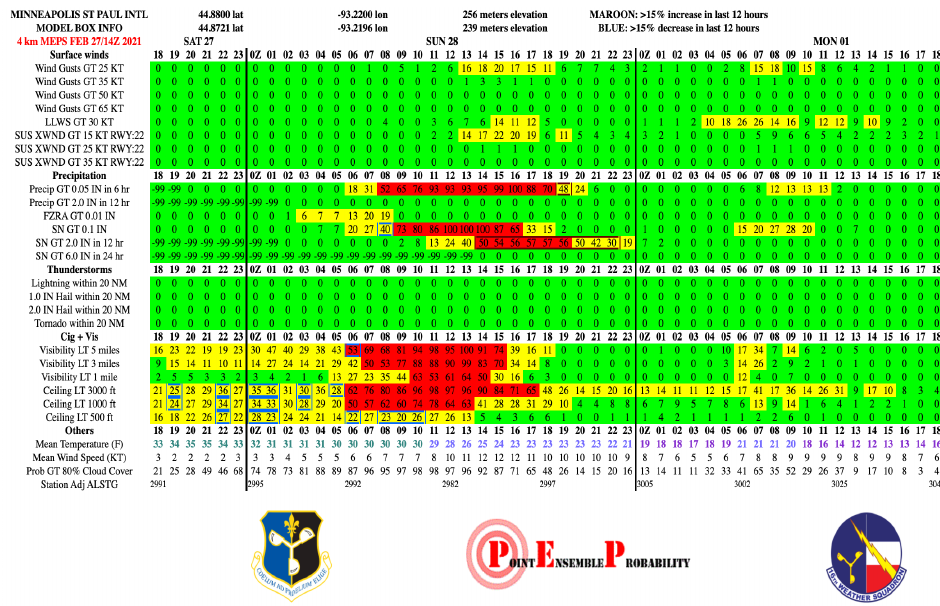
Figure 18. PEP bulletin from the 14 February 2021 1400 UTC run of the “Rolling” MEPS valid for Minneapolis, MN. Variables listed on the left hand side, with probabilities of exceedance for each valid time in rows to the right of the label. Yellow and red coloring designed to draw user attention to higher probabilities. Maroon (blue) box outlines indicate the rolling ensemble has increased (decreased) in probability by at least 15% in the last 12 hours of model runs. Note the elevated risk of snow, somewhat strong surface winds, and reduced visibility in the MEPS forecasts.